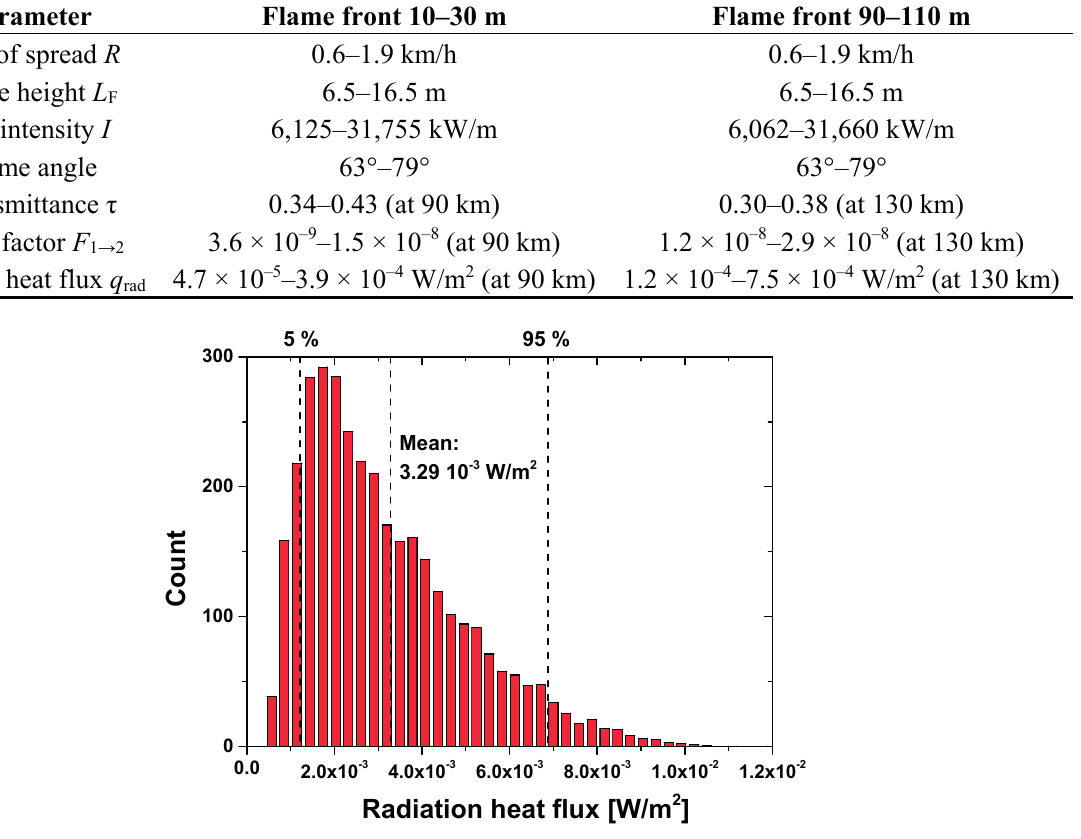
Figure 3. Radiation heat flux probability distribution (flame front 90–110 m) at a fire distance of 50